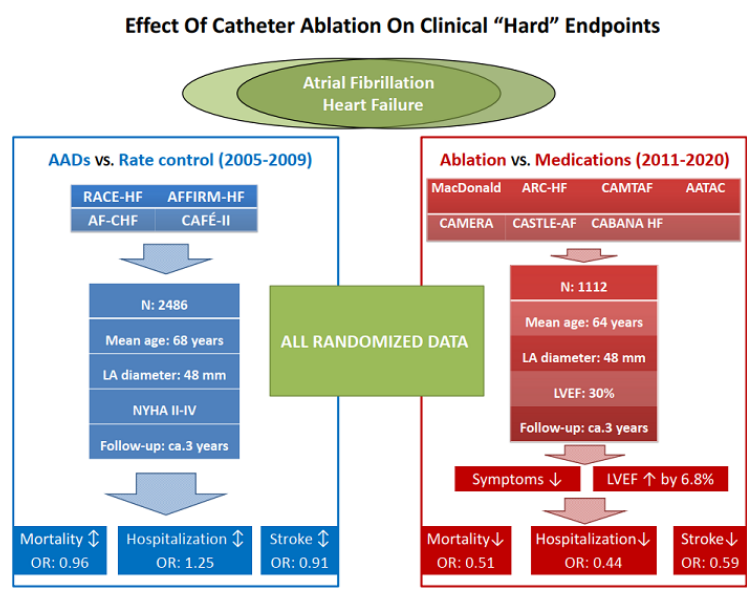
Figure 5. Effect Of Catheter Ablation on Clinical “Hard” Endpoints.